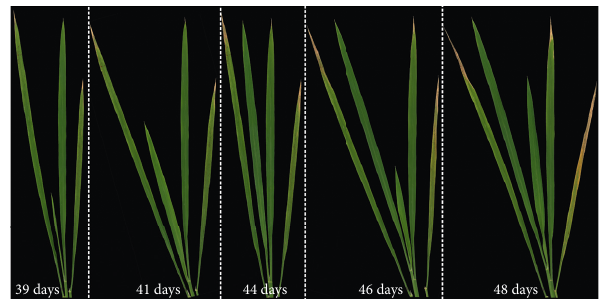
Figure 1: Under K deficiency, the difference of leaves’ symptoms with different growth stages (39days, 41days, 44days, 46days, and 48days indicate the days after seedling transplantation,